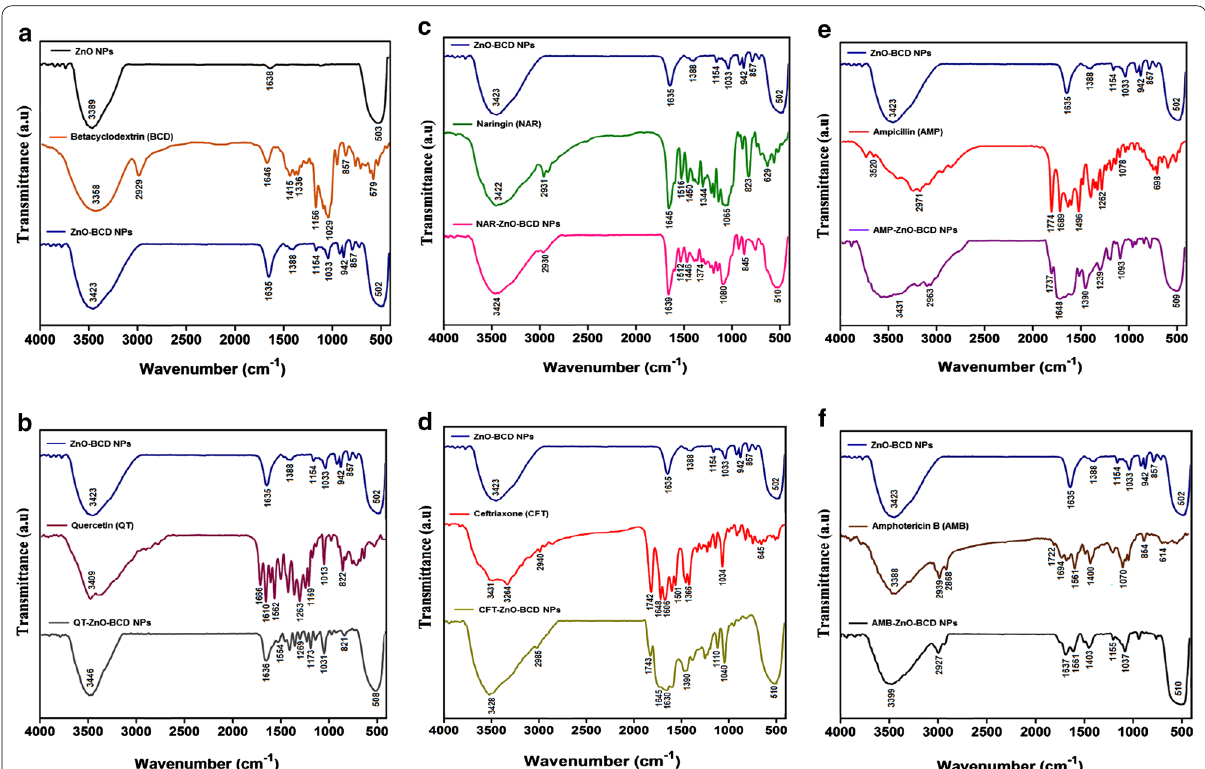
Fig. 4 a FT-IR spectra of ZnO-NPs alone is compared with BCD and BCD-ZnO-NPs complex, b relative FT-IR analysis of (ZnO-BCD NPs), quercetin (QT) and (QT-ZnO-BCD NPs), c comparative FTIR analysis of (ZnO-BCD NPs), naringin (NAR) and (NAR-ZnO-BCD NPs), d FTIR analysis of (ZnO-BCD NPs), ceftriaxone (CFT) and (CFT-ZnO-BCD NPs), e FTIR analysis of (ZnO-BCD NPs), ampicillin (AMP) and (AMP-ZnO-BCD NPs) and f FTIR analysis of (ZnO-BCD NPs), amphotericin B (AMB) and (AMB-ZnO-BCD NPs). All the spectra were acquired by employing IR-470 spectrometer (Shimadzu, Kyoto,